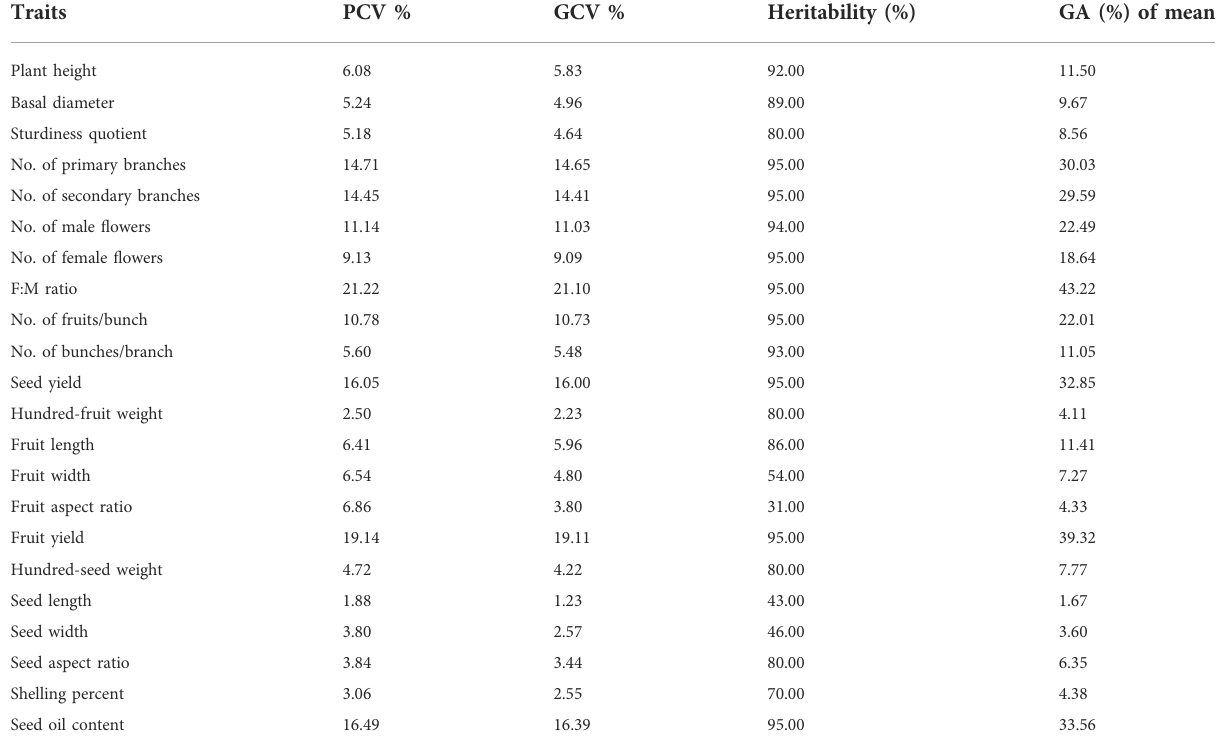
TABLE 3 Genetic estimates of hybrid clones for biometrical, fruit, and seed characters. Traits PCV